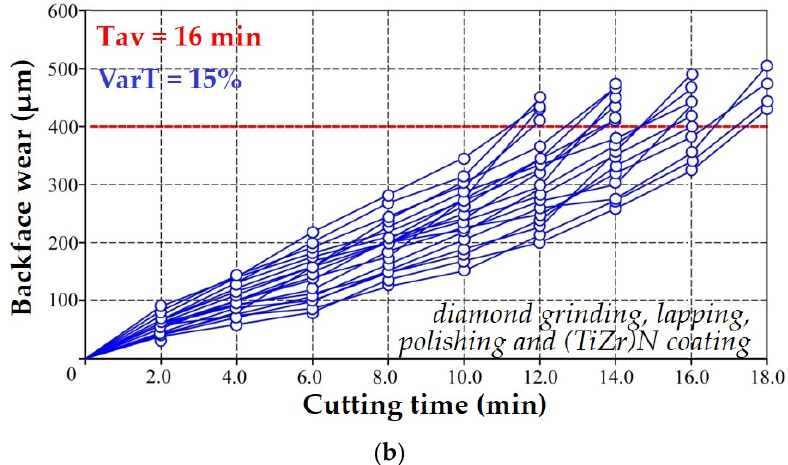
Figure 11. Group of “wear–cutting time” curves of cutting faces of ceramic inserts made of Al 2 O 3 +TiC after diamond grinding, lapping and polishing when milling hardened steel 100CrMn6 (V = 380 m/min, S = 0.15 mm/tooth, t = 1 mm) uncoated ( a ) and coated with (TiZr)N ( b ).